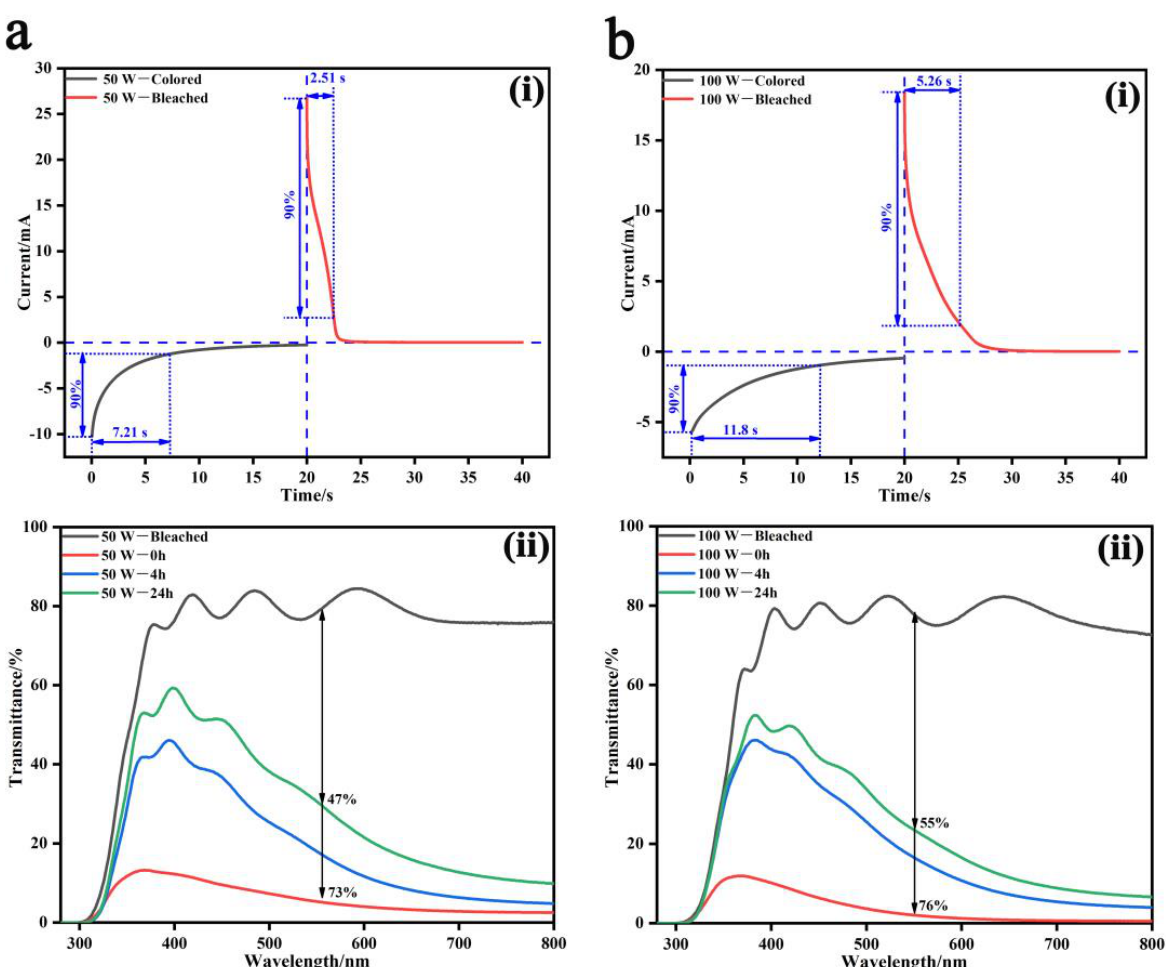
Figure 2. EC performances of the WO 3 films prepared at the sputtering power of 50 W ( a ) and 100 W ( b ); response times ( ai , bi ), and memory effects ( aii , bii ) where the WO 3 films were colored at 3 V for 5 min and then the transmittance spectra were recorded after different durations of 0 h, 4 h and 24 h.